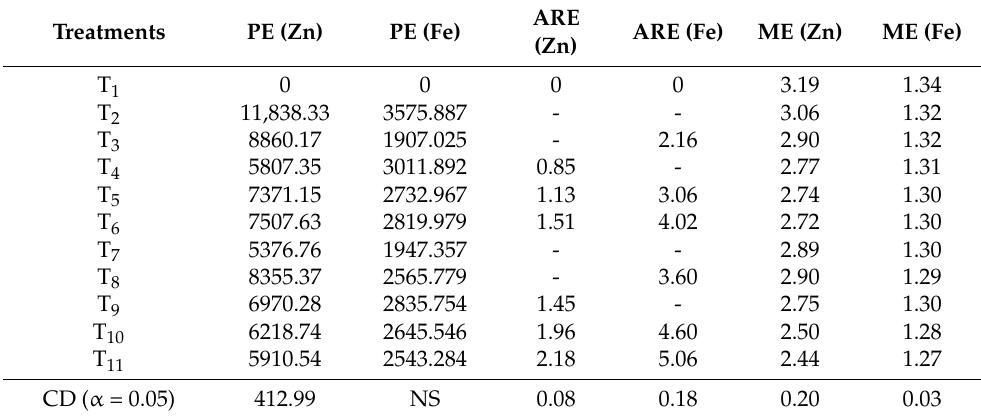
Table 2. Effect of micronutrient and urea spray on physiological efficiency (PE), apparent recovery efficiency (ARE %) and mobilization efficiency (ME) of nutrients in Indian mustard. Treatments PE (Zn) PE (Fe)